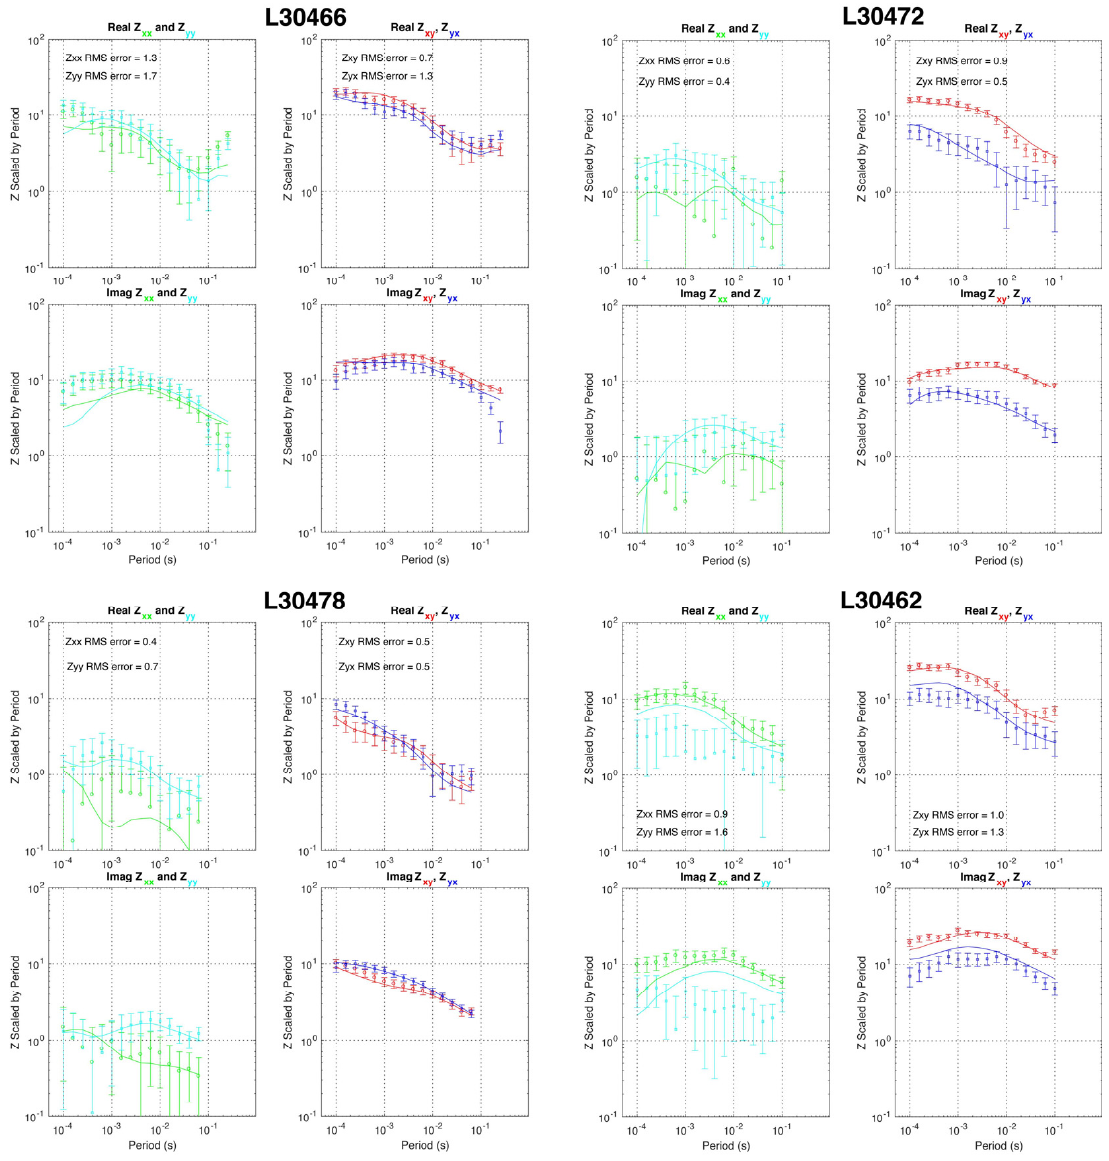
Figure A2. The observed and model response curves of apparent resistivity and phase data for the 3D inversion. The solid curves denote model responses. Small “T” signs emerging form dots on graph represent error bars.